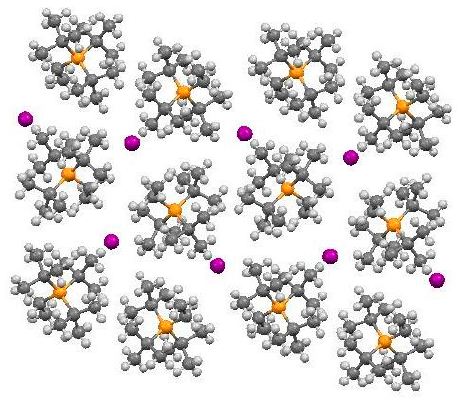
Figure 2. Crystal packing of 1a .